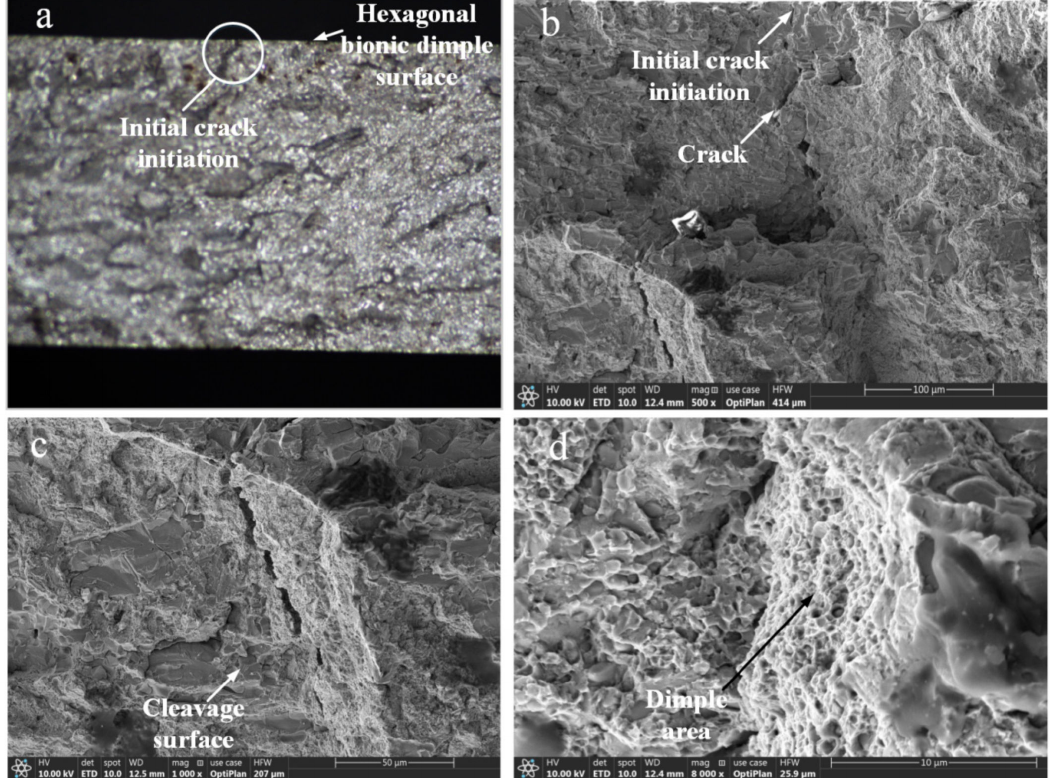
Figure 13. Observation results of macroscopic and microscopic characteristics of fatigue fracture of hexagonal bionic pit-shaped fatigue specimen: ( a ) macroscopic observation results of fatigue fracture of hexagonal bionic pit fatigue specimen; ( b – d ) observation on micro characteristics of fatigue fracture surface of hexagonal bionic pit fatigue